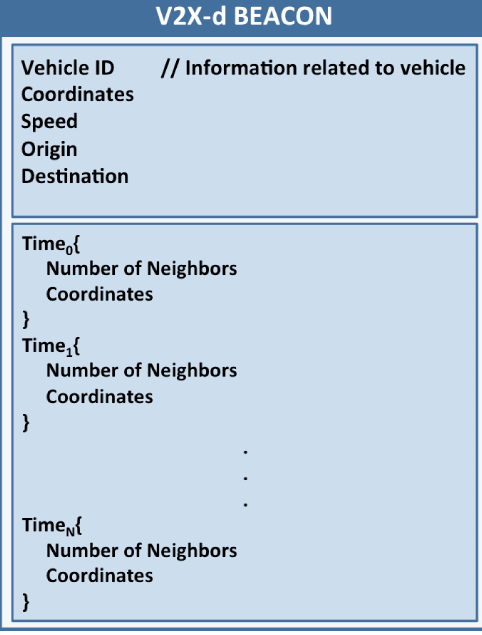
Figure 3. V2X-d beacon